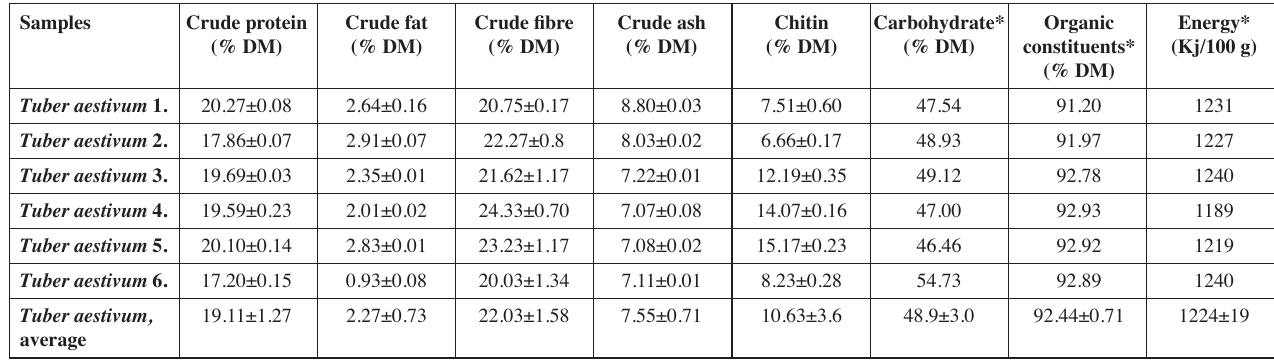
Tab. 1: Different macrocomponents (crude protein, -fat, -fiber, ash, chitin, carbohydrate contents in % of DM, and energy level in Kj/100 g) of Tuber aestivum (mean ±SD)